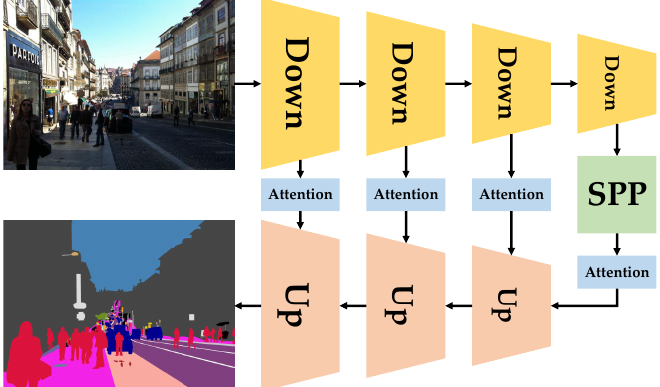
Figure 5. The real-time SwaftNet [2] architecture for swift and accurate semantic segmentation. The downsampling and upsampling paths are connected with attention operations to improve the